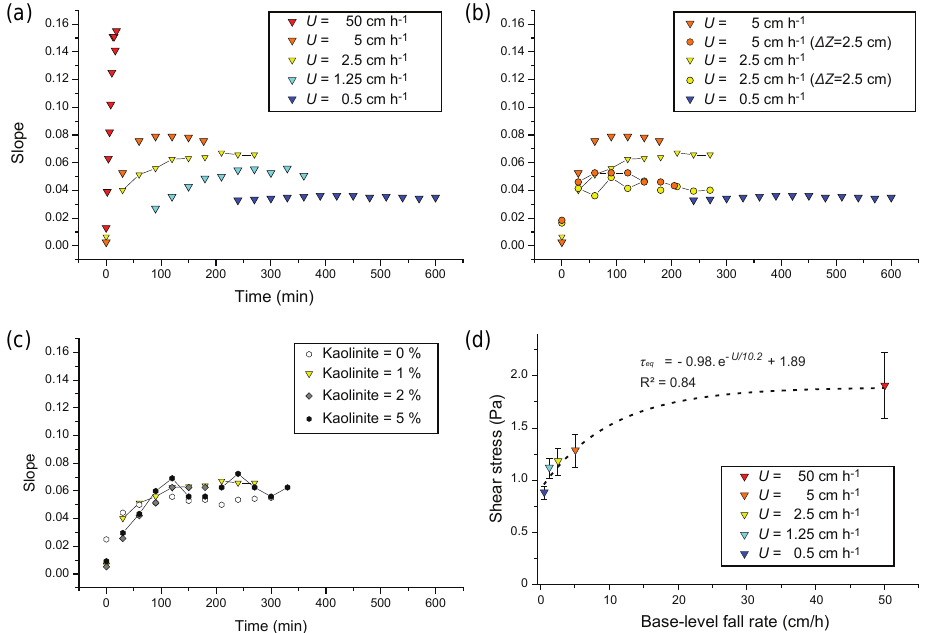
Figure 7. (a) – (c) Evolution of mean slope of the experiments with time for different sets of experiments. (a) Evolution with base-level fall rate. (b) Evolution with different base-level fall styles. For experiments 5, 7 and 8 (respectively represented by the blue triangles, yellow circles and orange circles), the minimum time between each base-level drop is 30min. (d) Evolution of the equilibrium shear stress as a function of their base-level fall rate for experiments where (cid:49)Z = 0.25cm. Exponential fit is shown with a dashed